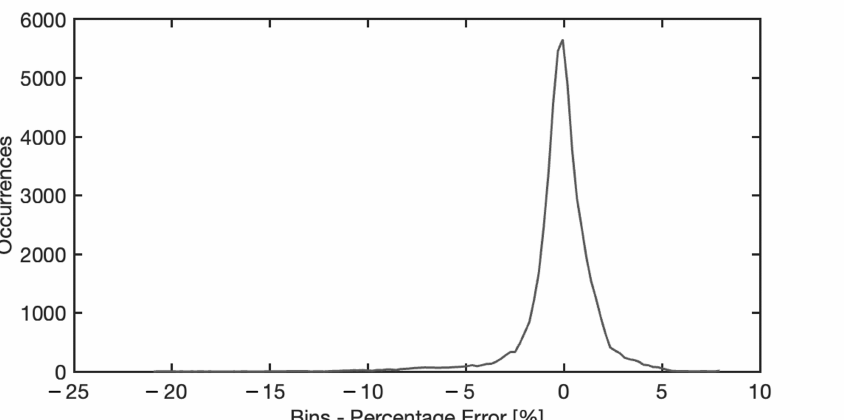
Figure 12. Mean absolute percentage error statistical distribution for the complete set of samples and acquisition times and for the entire spectral range.